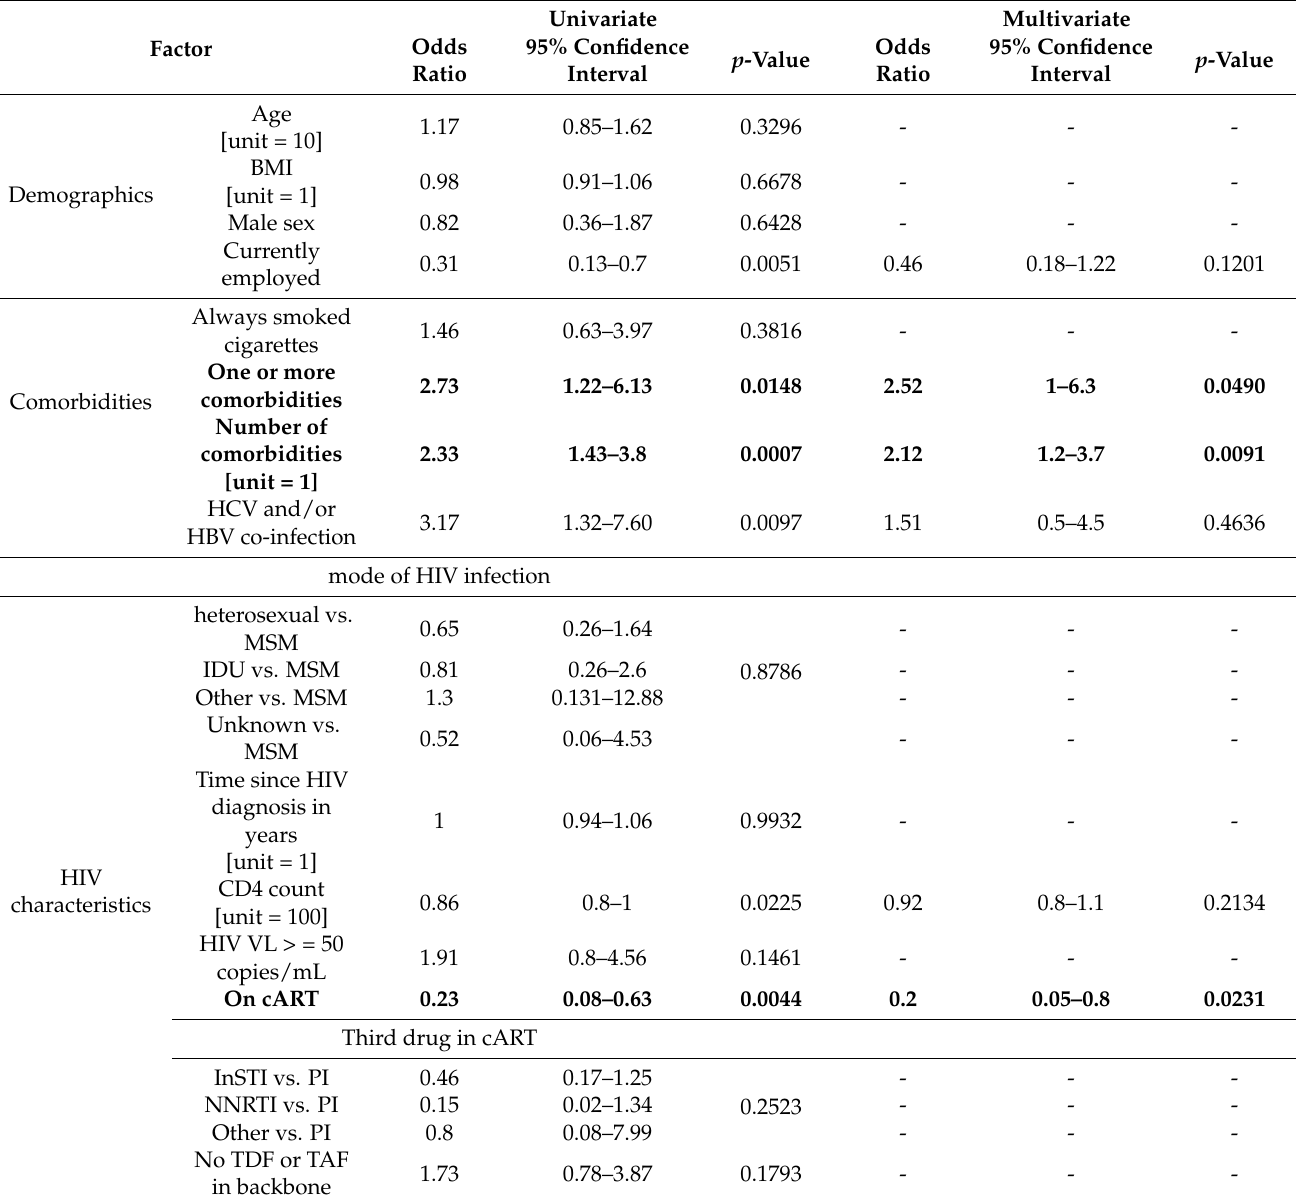
Table 3. Univariate and multivariate logistic regression analyses of the factors associated with poor COVID-19 outcome in HIV-positive